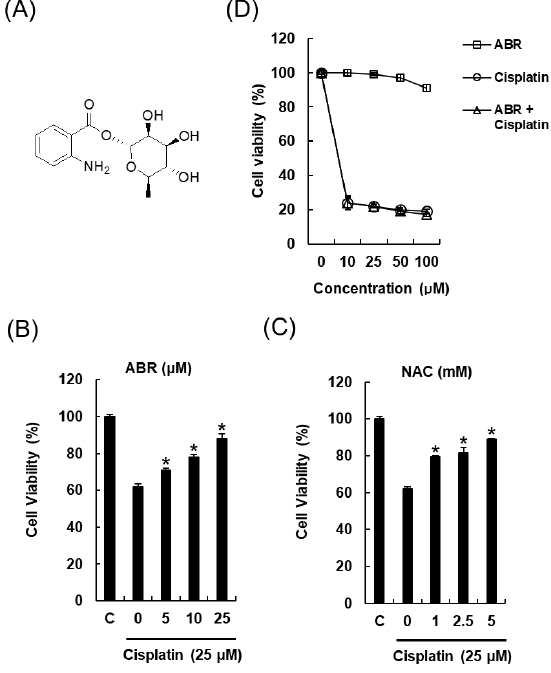
Figure 2. Protective effect of 1- O -(2-aminobenzoyl)-α- L -rhamnopyranoside (ABR) in